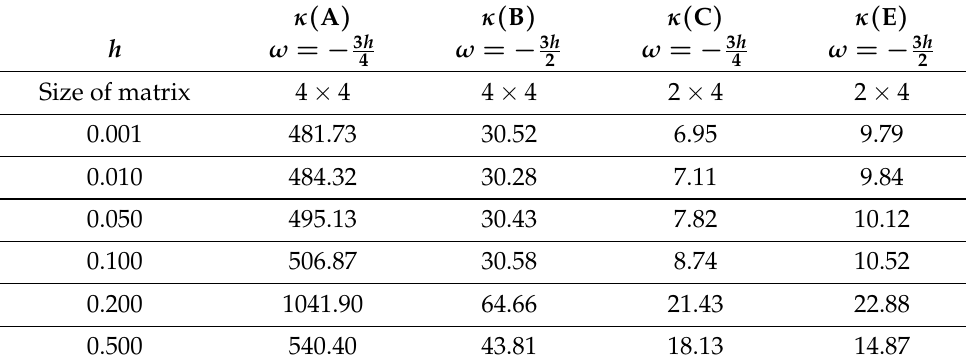
Table 2. Comparing the condition numbers for the matrices derived from Example